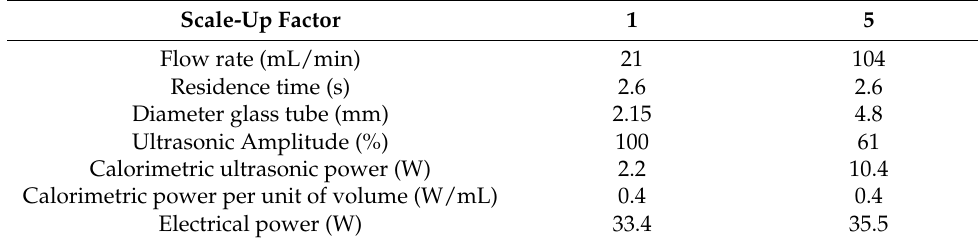
Table 3. Relevant parameters for the scale-up